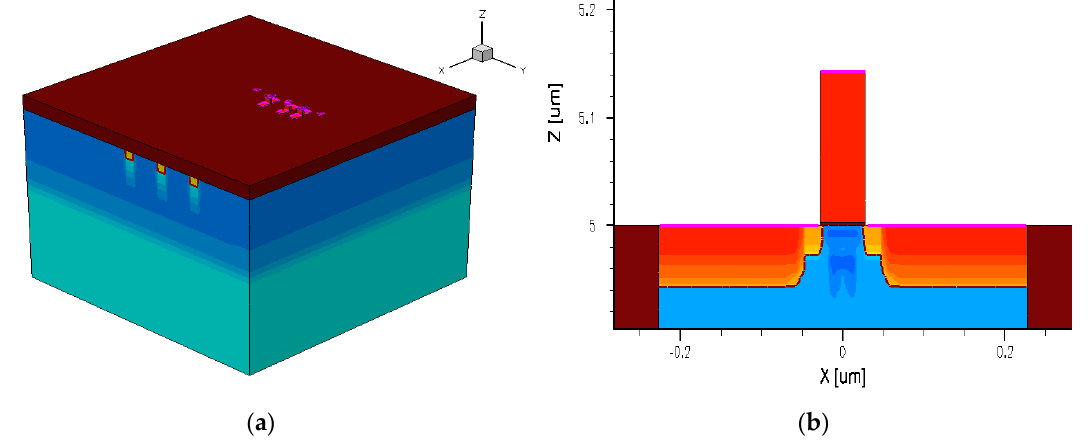
Figure 1. NMOS TCAD structure: ( a ) 3D view and ( b ) 2D cross-section view.